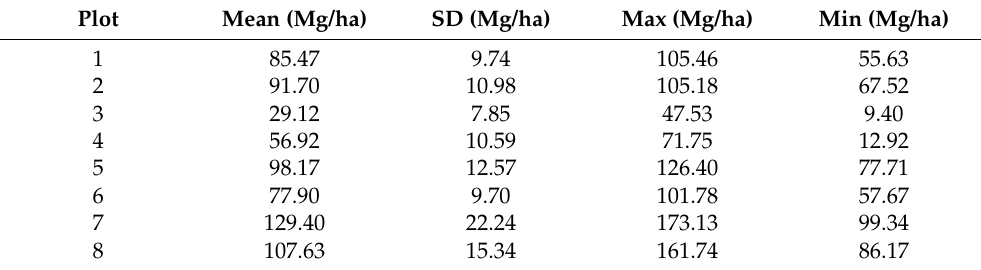
Table 3. Mean, standard deviation (SD), minimum (Min), and maximum (Max) values of individual plot carbon stock density maps produced using the data fusion